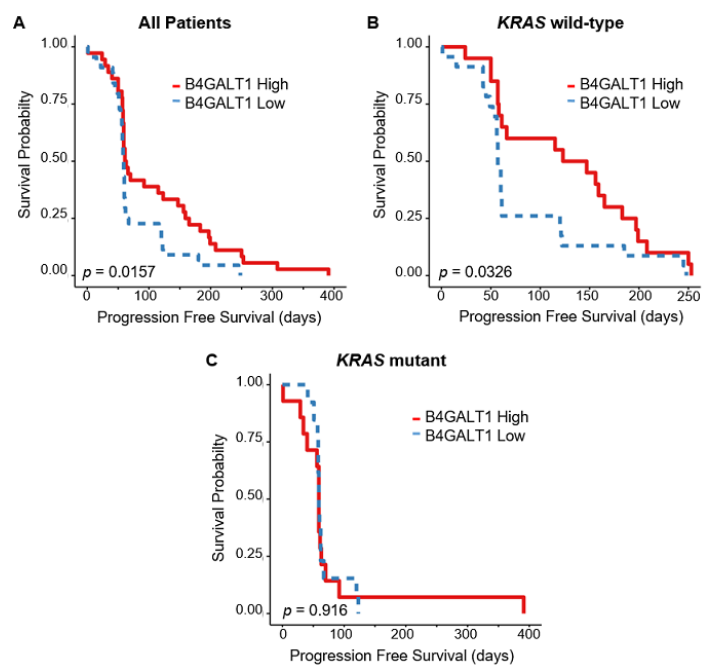
Figure 4. Kaplan–Meier survival curves of B4GALT1 high (red line) and low (blue line) expression groups in GEO cohort 5 ( n = 70) according to KRAS mutational status. ( A ) PFS in all patients, ( B ) PFS in wild-type (WT)- KRAS patients, ( C ) PFS in mutant KRAS patients.